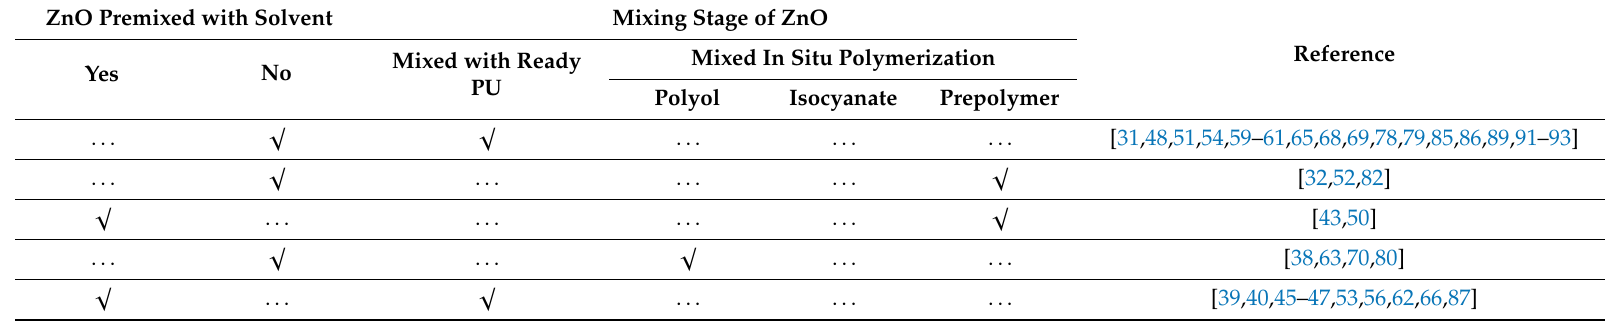
Table 2. Mixing of pristine ZnO during PU / ZnO dispersion preparation.